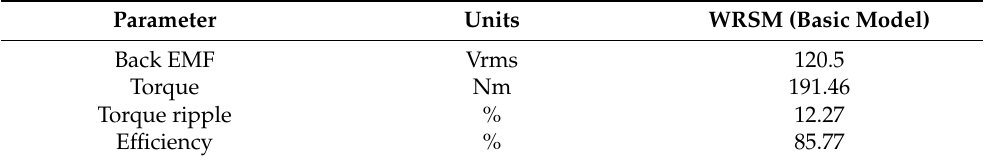
Figure 6. Output torque (basic model) at rated speed. Table 3. Performance of the basic